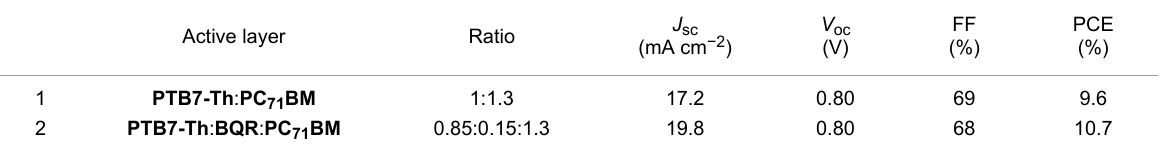
Table 6: Photovoltaic Performances of PTB7-Th : BQR : PC 71 BM ternary BHJ solar